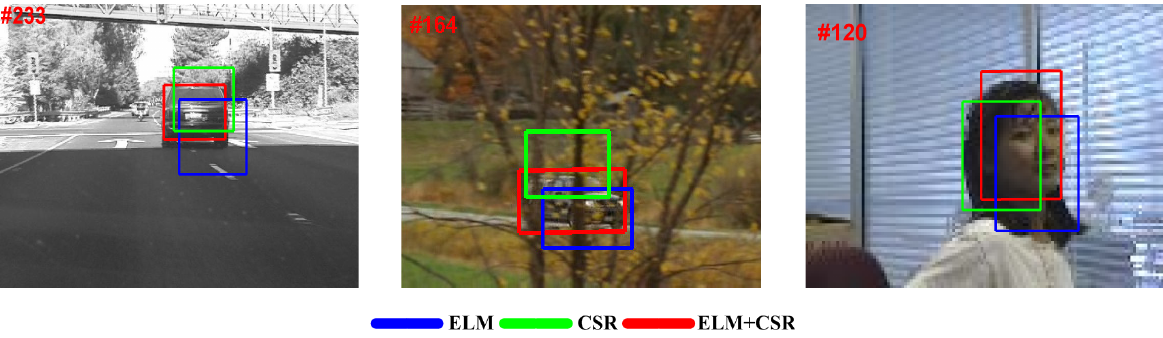
Figure 5. Some tracking results for self-comparisons on three video sequences: Car4, CarScale, Girl (from left to